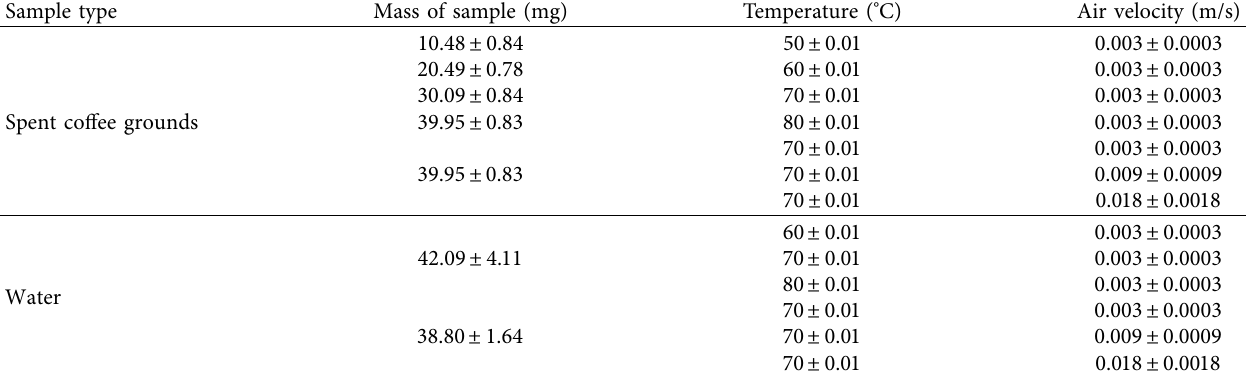
Table 1: Experimental conditions in which the drying and evaporation processes, respectively, were analyzed. Sample type